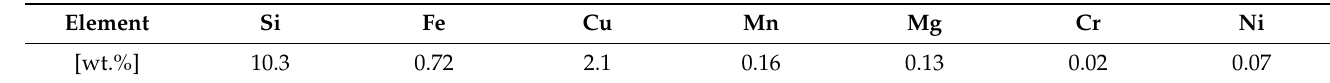
Table 1. Chemical composition of AlSi9Cu3(Fe)